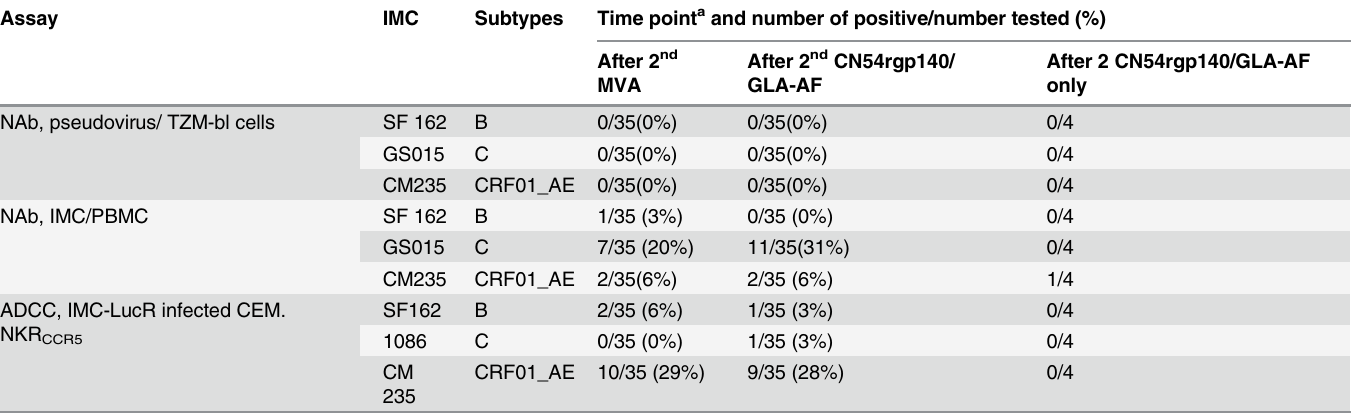
After 2 nd CN54rgp140/ After 2 nd MVA